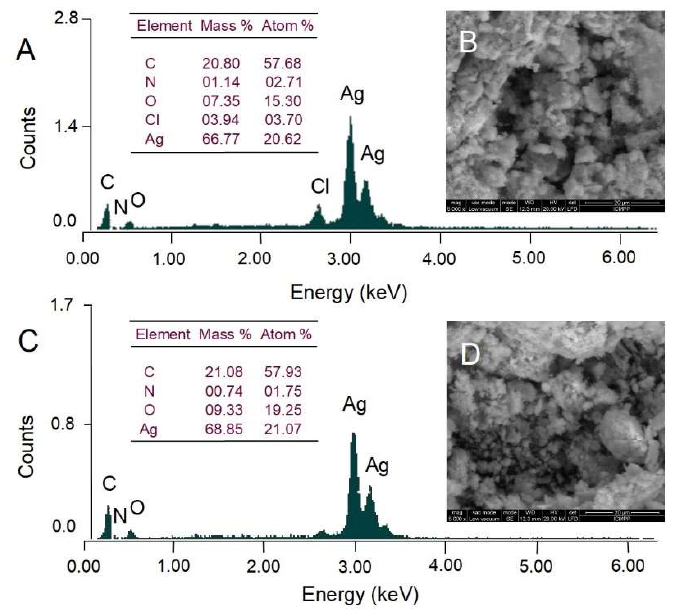
the protocol used for AgNPs synthesis was simple and provided spherical AgNPs with Figure 6. Elemental composition (EDX analysis) and scanning electron microscopy (SEM) micrographs of Picea abies ( A , B ) and Pinus nigra ( C , D ) bark extract derived AgNPs.